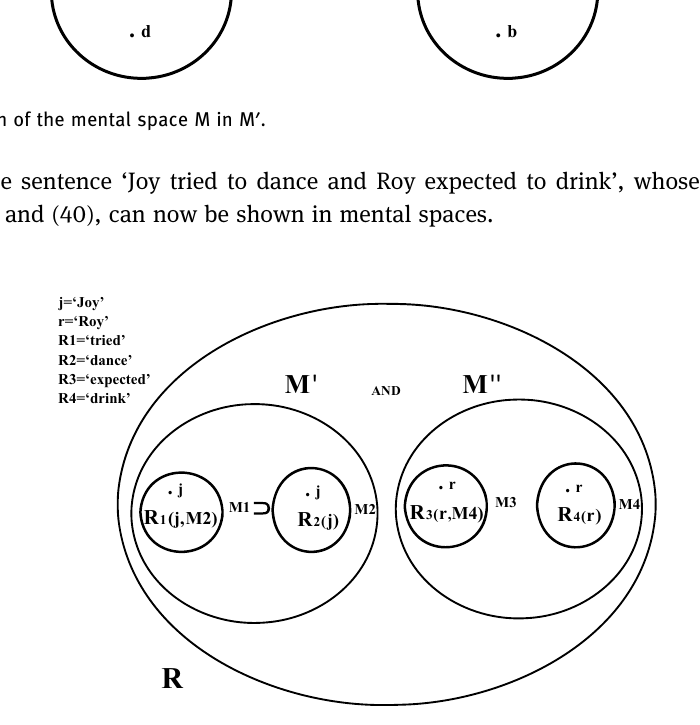
Figure 6: Mental spaces for the sentence ‘ Joy tried to dance and Roy expected to drink ’